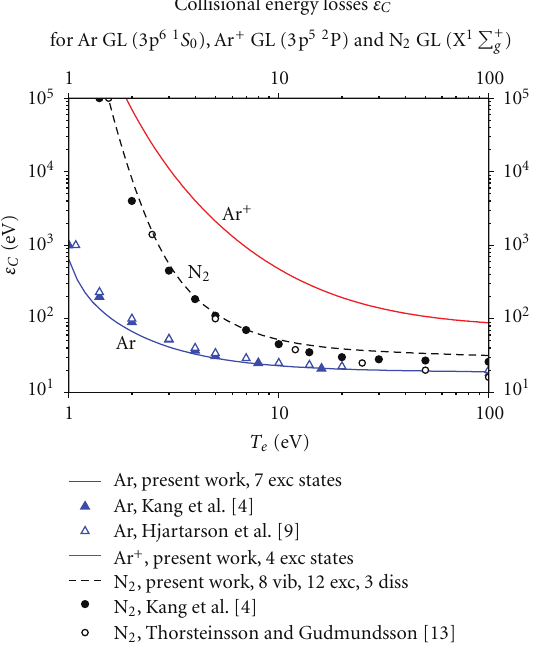
Figure 2: Collisional energy losses for Ar, Ar + , and N 2